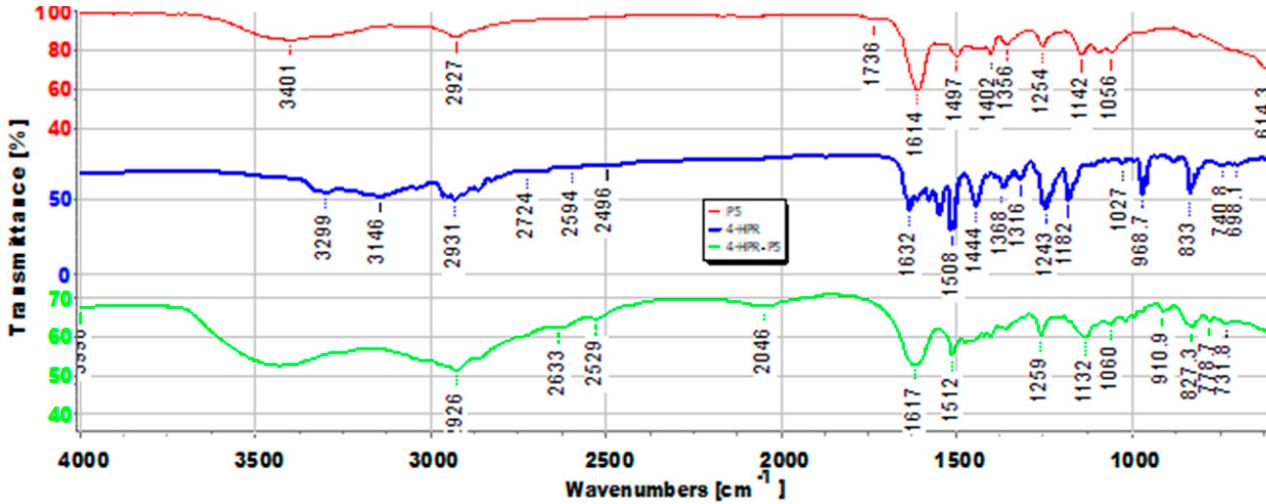
Figure 1. FTIR spectra of 4-HPR-P5 NPs (green line), P5 (red line), and pristine 4-HPR (blue line) for easier comparison.